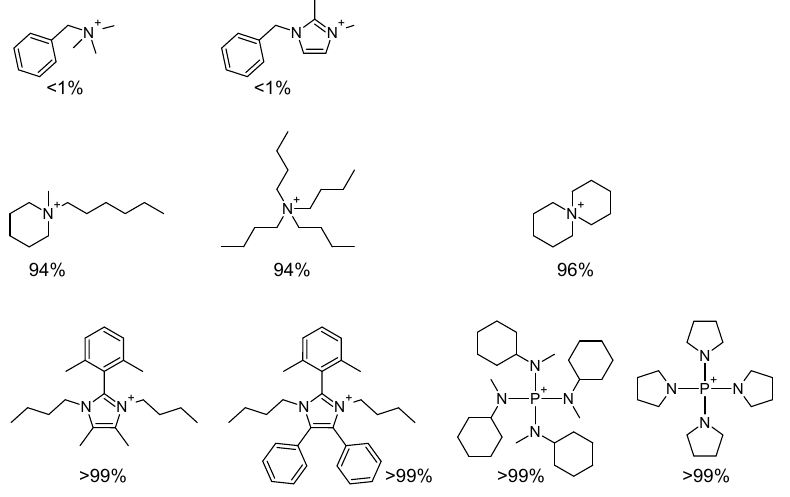
Scheme 1. Examples of model compound stability characterized as the percentage remaining